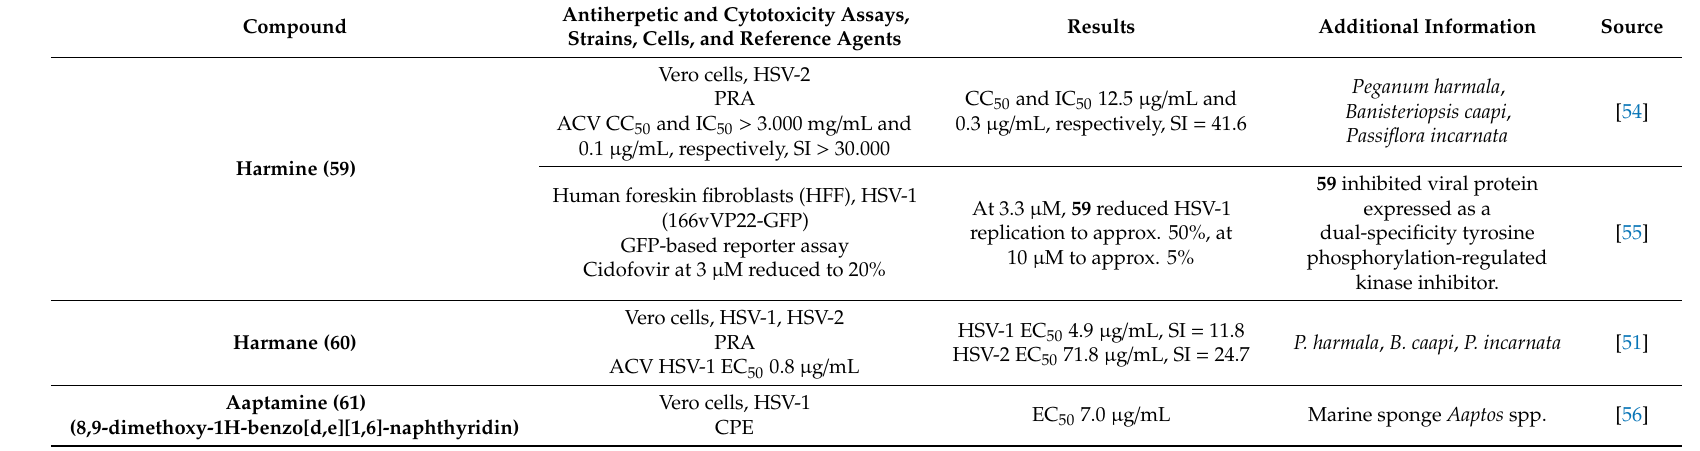
Table 2. The overview of alkaloids with anti-HSV